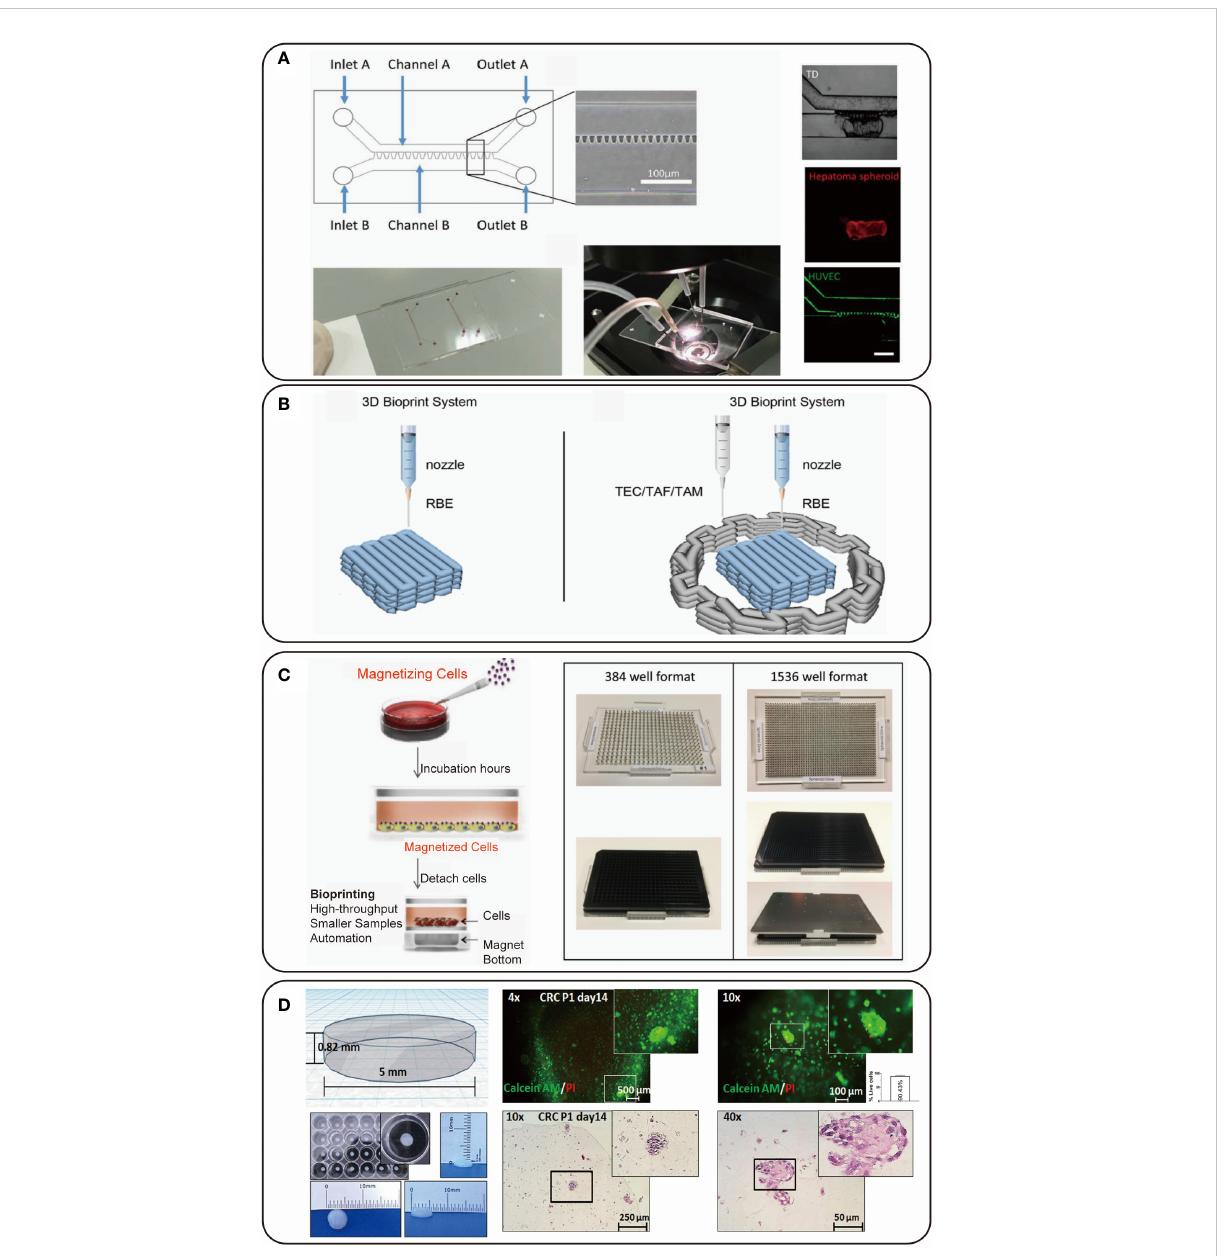
FIGURE 2 Representative fi gures of 3D bioprinted hepato-pancreato-biliary (HPB) cancer models. (A) The design of a 3D bioprinted hepatocellular carcinoma (HCC) model combined with micro fl uidic technology; adapted with permission (30), copyright 2019 IOP Publishing. (B) A 3D bioprinted model with cholangiocarcinoma (CCA) cells and stromal cells; adapted with permission (65), copyright 2022 Frontiers. (C) A 3D bioprinted pancreatic cancer model for high-throughput screening (HTS); adapted with permission (66), copyright 2022 ELSEVIER (open access). (D) A 3D bioprinted colorectal cancer model derived from patient; adapted with permission (14), copyright 2021